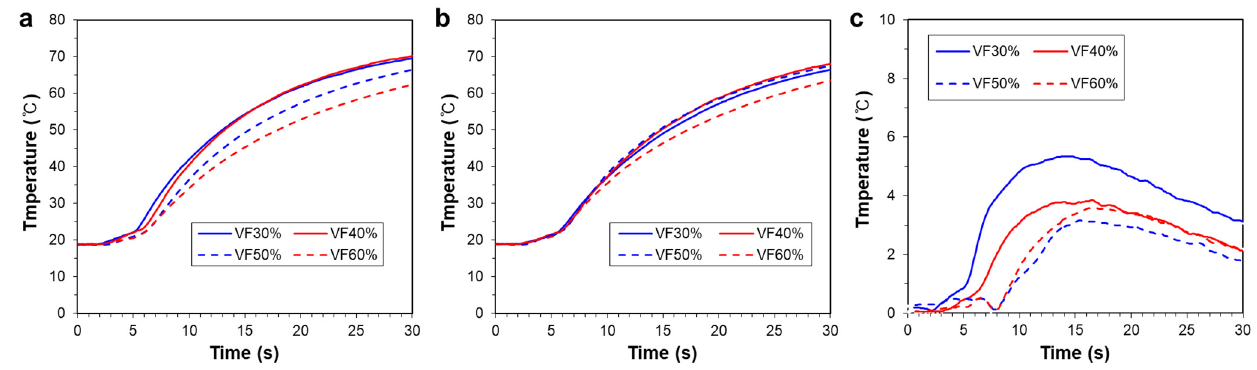
Figure 12. Temperature changes on the top surfaces for various volume fractions: ( a ) at Point 1 (P 1 ); ( b ) at Point 2 (P 2 ). ( c ) Temperature difference between P 1 and P 2.